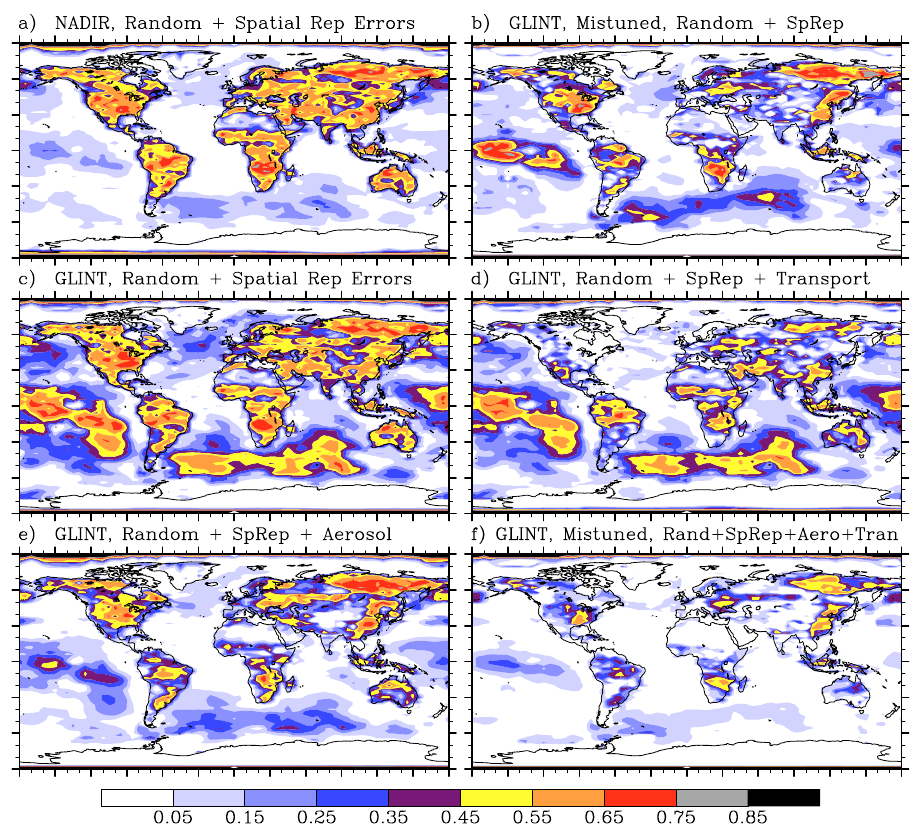
Fig. 8. Fractional error reductions in 7-day CO 2 fluxes, using full-year RMS errors, after 50 iterations of the optimization method, for experiments: (a) #1, control case (random measurement errors and spatial representation errors only) using nadir data; (c) #2, control case using glint data, (b) #3, mistuned case, glint, (d) #4, random errors + aerosol biases, glint, (e) #5, random + transport errors, glint, and (f) #6, random errors + aerosol biases + transport errors + mistuning effects,